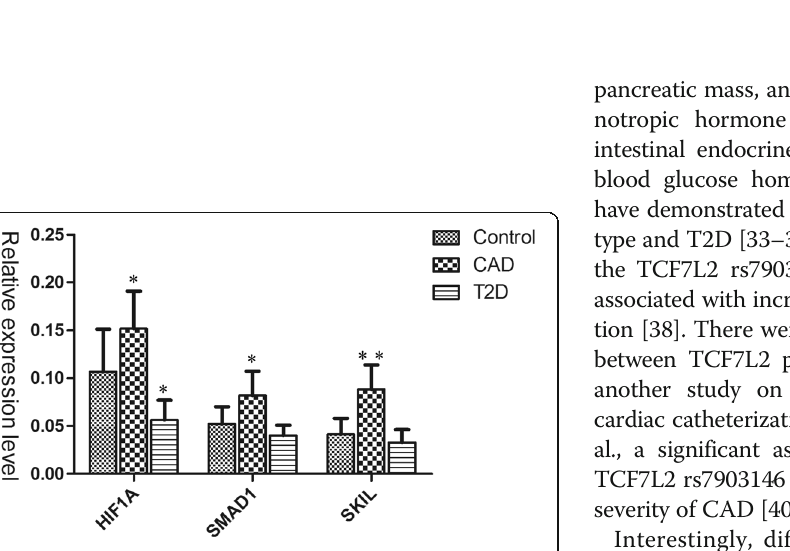
Fig. 2 The CAD-specific PPI networks of 69 dysregulated genes. Red nodes indicate up-regulated genes in CAD, and blue nodes indicate down-regulated genes in CAD. Pink nodes indicate genes interacting with the differentially expressed genes, and larger icons indicate hub proteins